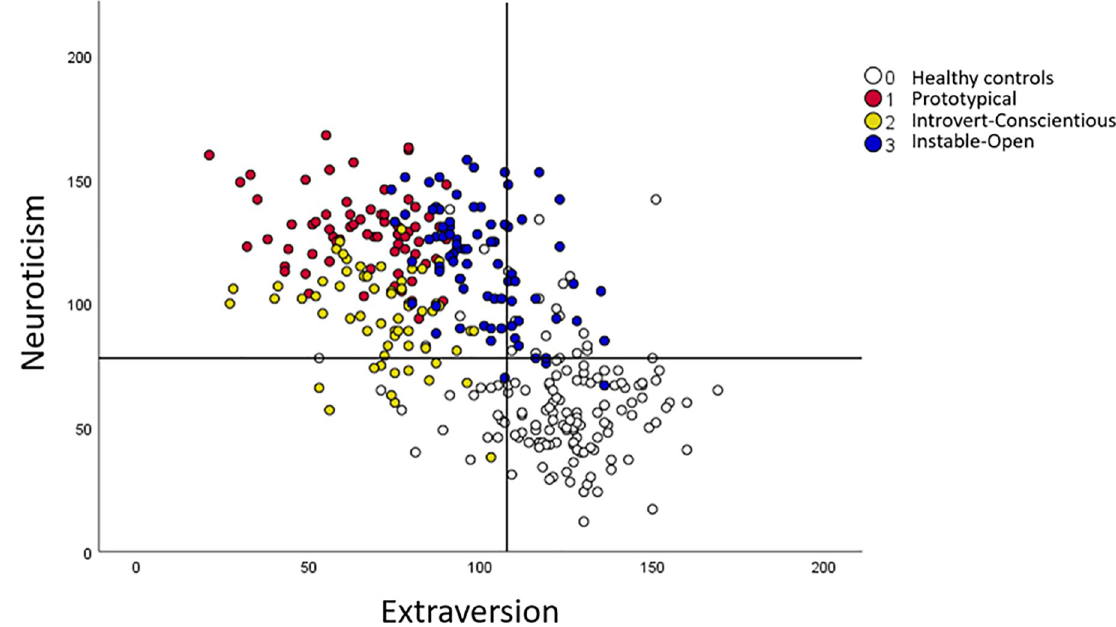
Fig 2. Distribution of three clusters of social anxiety disorder patients and healthy controls along the neuroticism and extraversion dimensions. The crosshair denotes Swedish norm values for neuroticism (M = 78.0, SD = 22.5) and extraversion (M = 107.6, SD = 20.7)